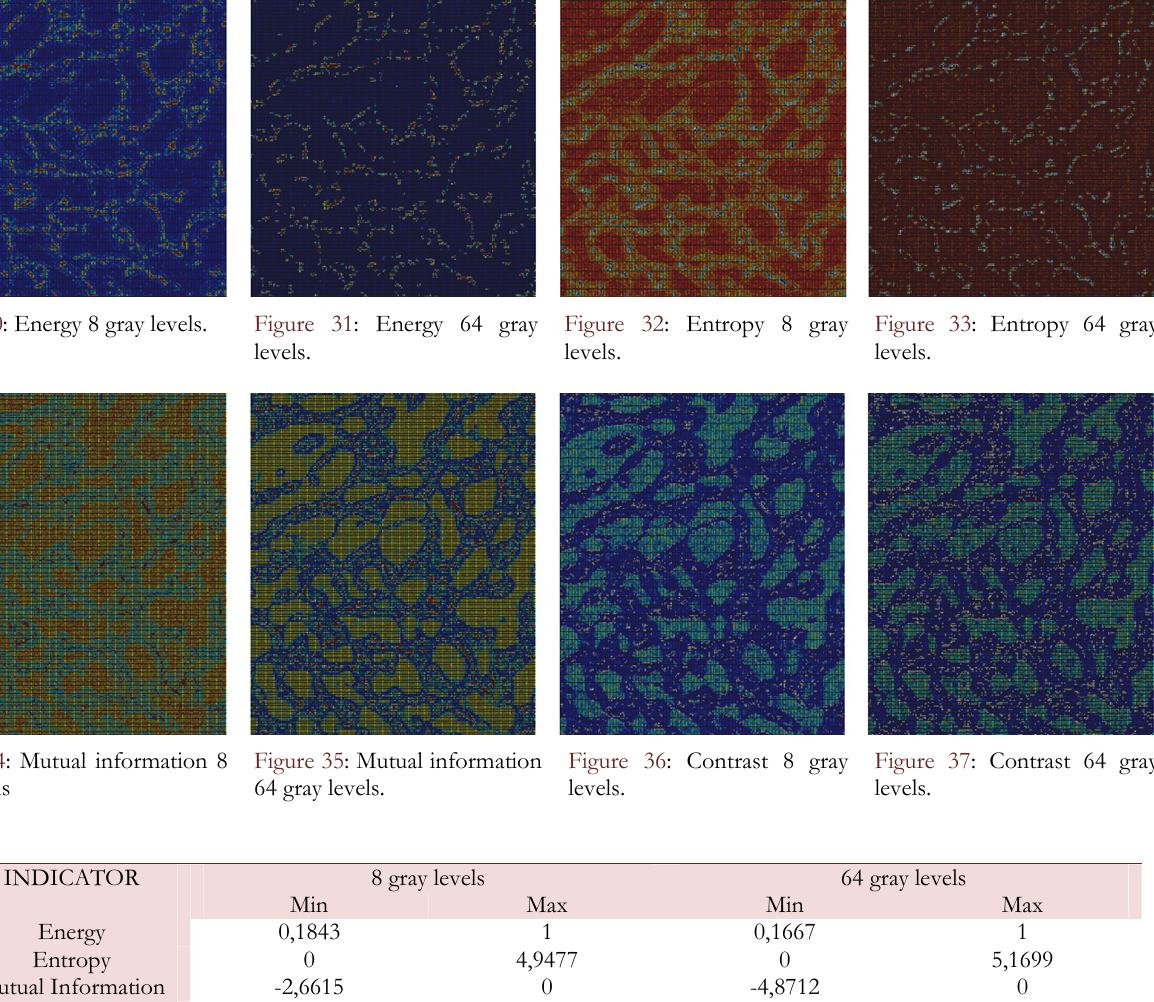
Table 3: Minimum and maximum values assumed by the